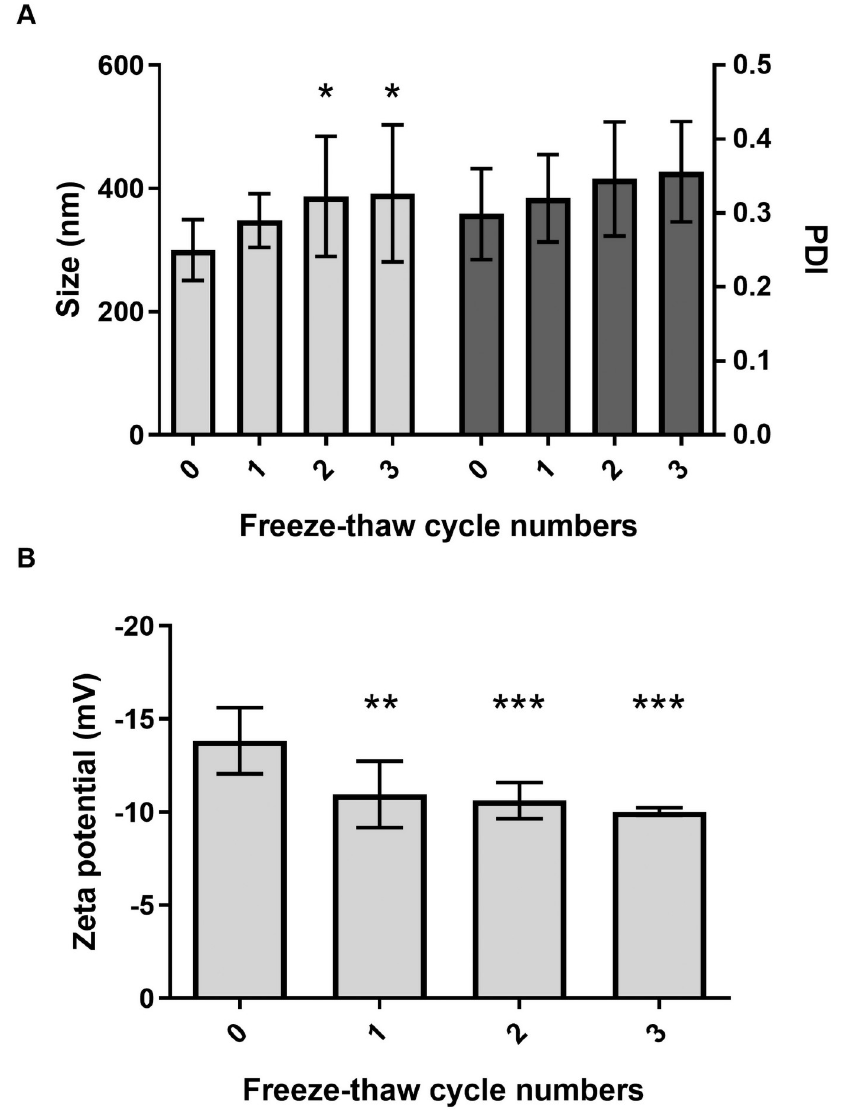
Fig 4. Determination of KPEVs stability after freeze-thaw cycles. The size distribution (A, left), PDI (A, right), and zeta potential (B) of the KPEVs after 0 to 3 cycles were analyzed using DLS. The experiments were performed in at least triplicates, and the data are presented as the mean ± SD. The statistical analysis was performed using two-way ANOVA followed by the Bonferroni test. ( � ), ( �� ), and ( ��� ) indicate P-values of p � 0.05, p � 0.01, and p � 0.001 compared to freeze-thaw cycle